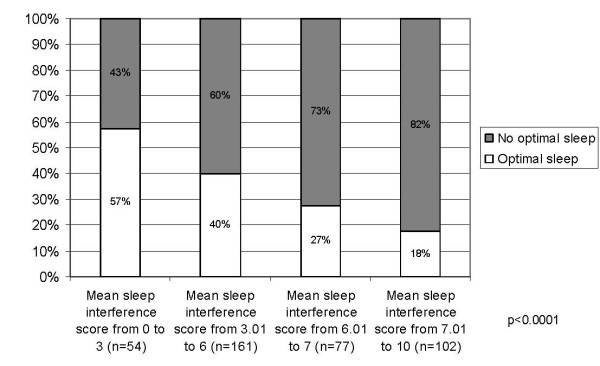
Percentage of patients with optimal sleep according to the mean sleep interference score at baseline; p: chi-square p-value for between-group comparison.